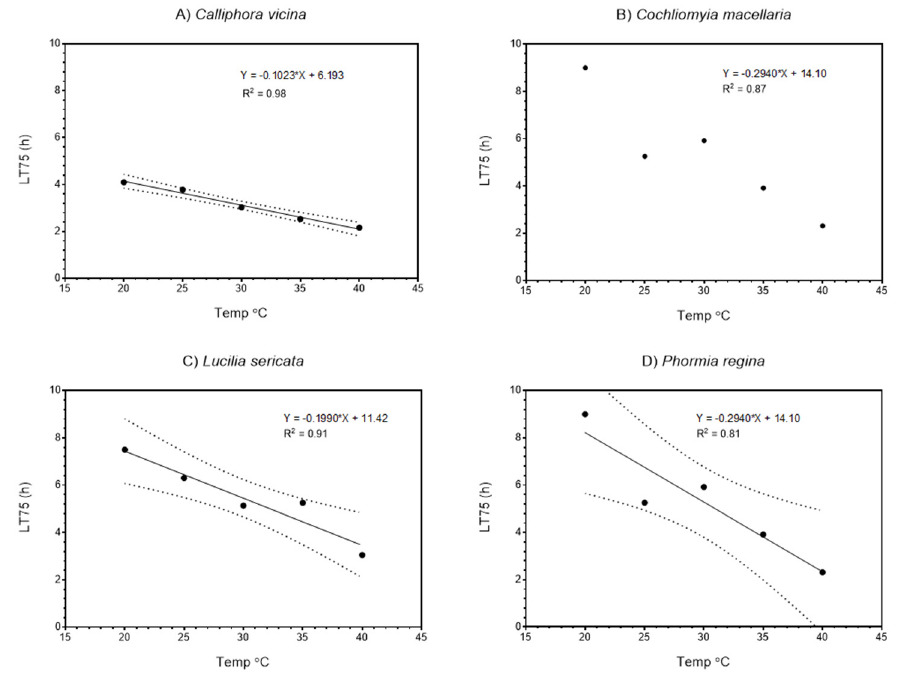
Figure 2. Relationships between LT75 (lethal time to 75% survivorship) and temperature (°C) for 3rd-stage larvae of four species of blow fly: ( A ) Calliphora vicina , ( B ) Cochliomyia macelleria , ( C ) Lucilia sericata , and ( D ) Phormia regina . Dotted lines indicate 95% confidence limits. As expected, survival was substantially greater at lower temperatures than higher temperatures. The range of survival times across species and temperature were a minimum of 2.2 h at 40 ◦ C for C. vicina (Figure 1a) and a maximum of 9.0 h at 20 ◦ C for C.